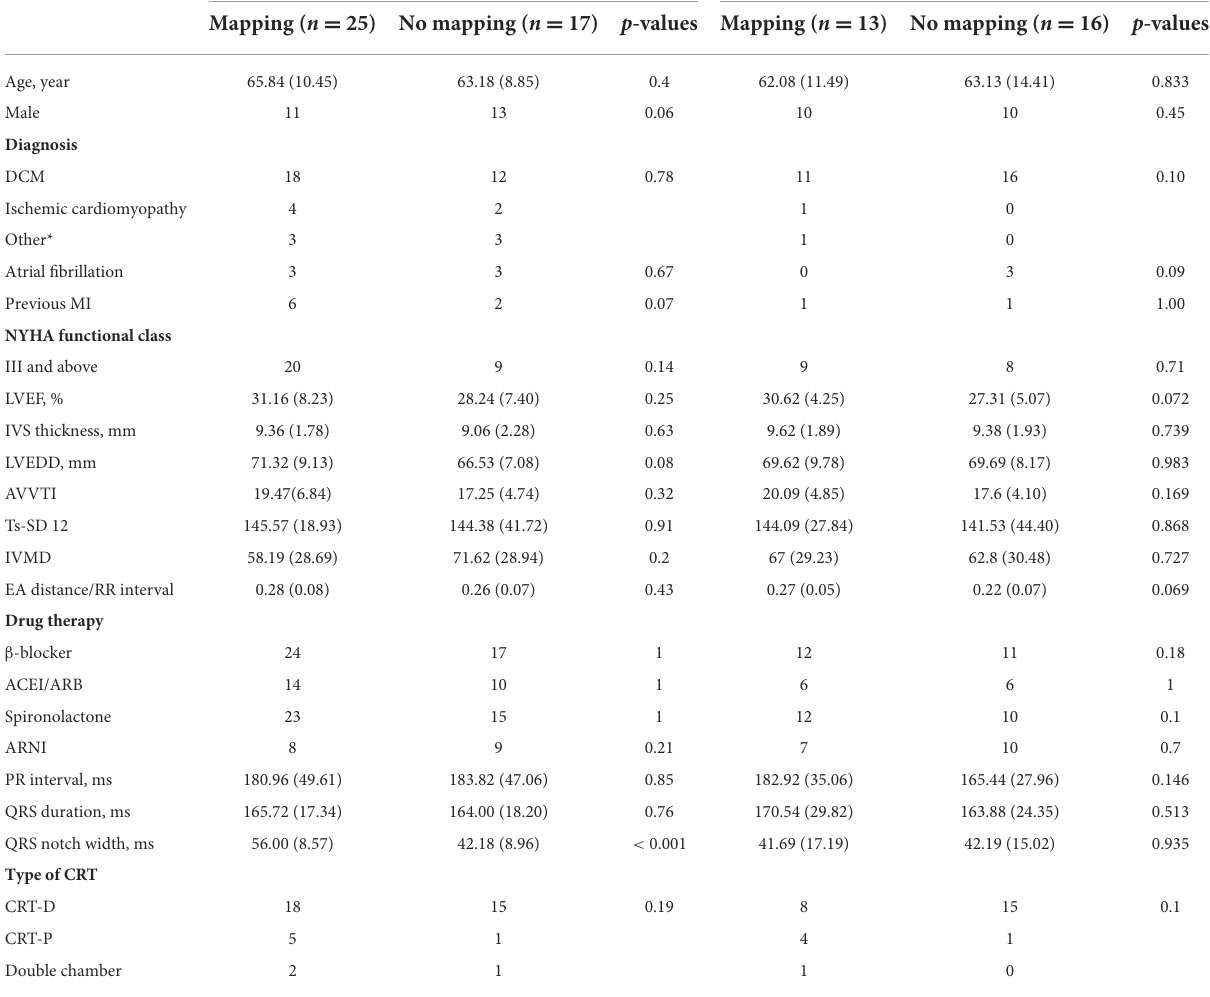
TABLE 1 Baseline characteristics of patients analyzed ( n = 71). LBBAP CVP